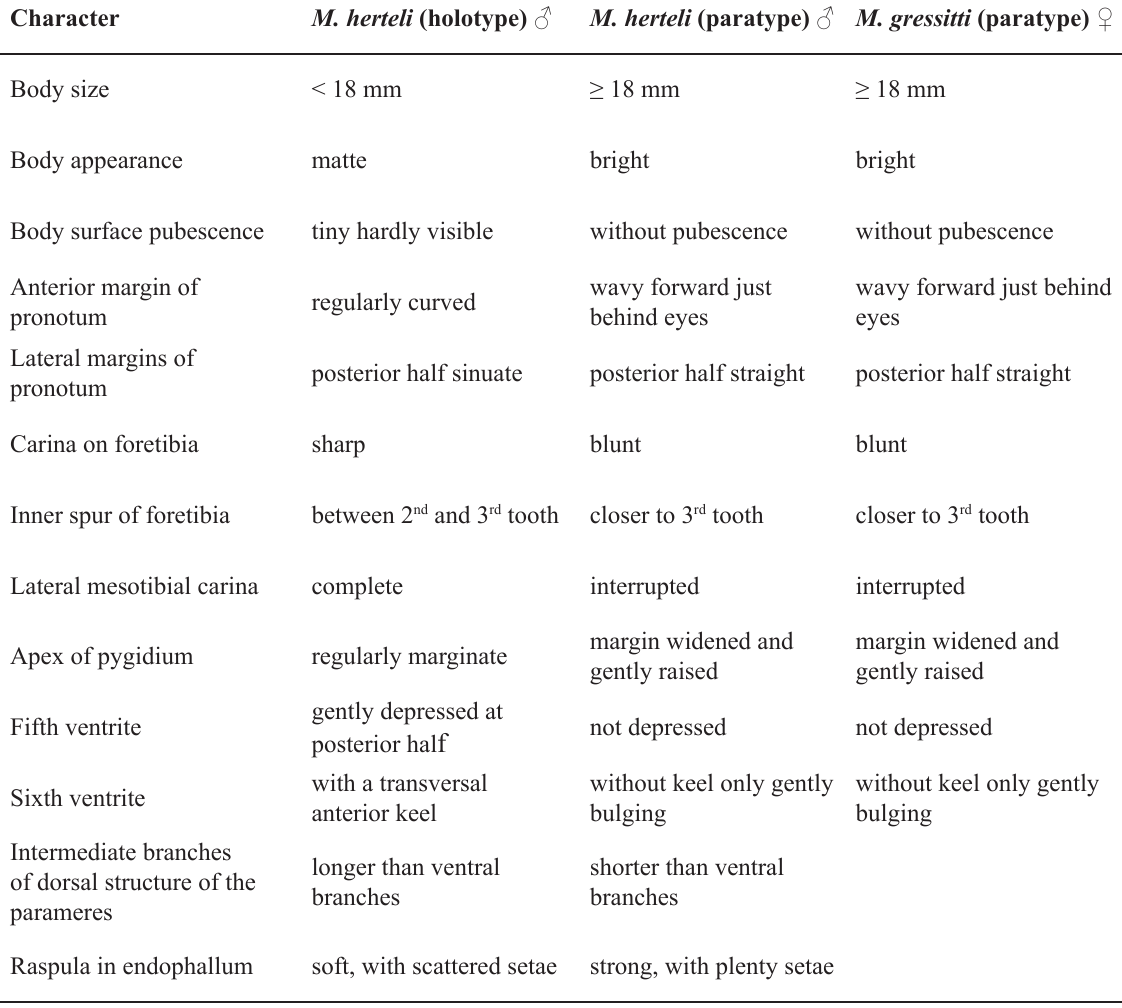
Table 3. Differences between holotype and paratype of M. herteli (Frey, 1971) and paratype of M. gressitti (Frey, 1970)